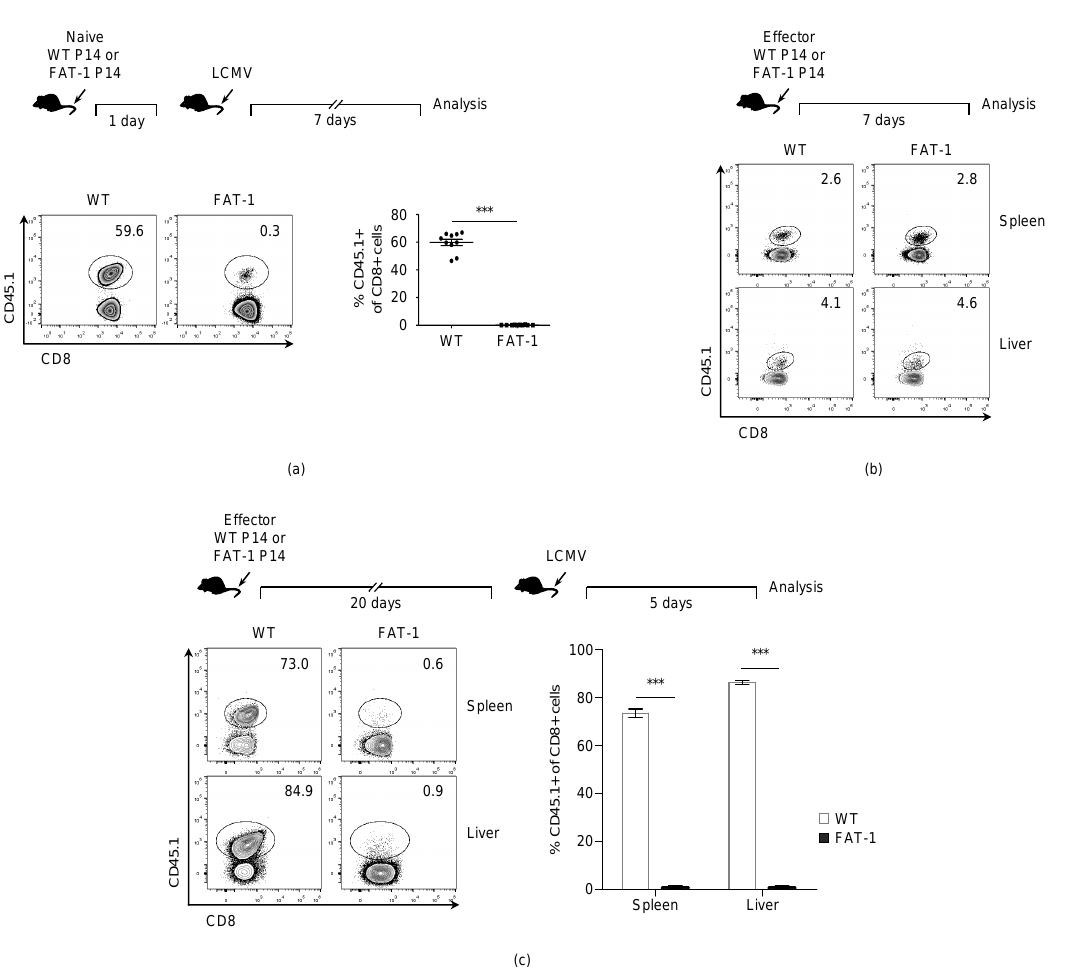
Figure1. The n -3polyunsaturatedfattyacid(PUFA)decreasestheCD8responseagainstthelymphocytic choriomeningitis virus (LCMV) infection. ( a ) 1.0 × 10 5 wild type (WT) P14 or FAT-1 P14 cells were transferred into the naïve WT mice via tail vein intravenous injection followed by an intraperitoneal infection with 2.0 × 10 5 focus forming units (FFUs) of the LCMV Armstrong after 24 h. Seven days after infection, the mice were sacrificed and splenocytes were analyzed. ( b ) 1.5 × 10 6 in vitro-activated (e ff ector) WT P14 or FAT-1 P14 cells were transferred intravenously into the naïve WT mice. Seven days after the transfer, the mice were sacrificed to analyze the P14 T cells in the livers and spleens. ( c ) 1.5 × 10 6 in vitro-activated WT P14or FAT-1 P14 cells were transferred intravenously into the naïve WT mice. Twenty days after transfer, the mice were challenged with 1.5 × 10 5 FFUs of LCMV clone 13 via intravenous injection. Five days after challenge, the mice were sacrificed to analyze P14 T cells in the livers and spleens. ***, p <